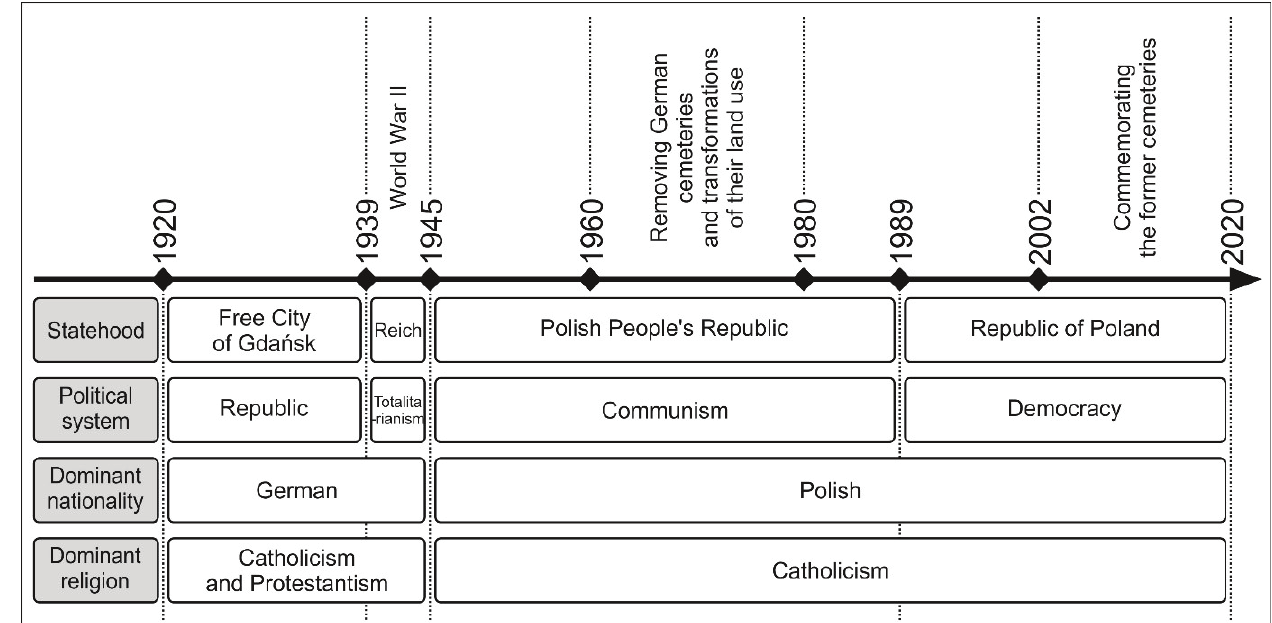
Figure 4. Social and political changes in Gdansk in the last 100